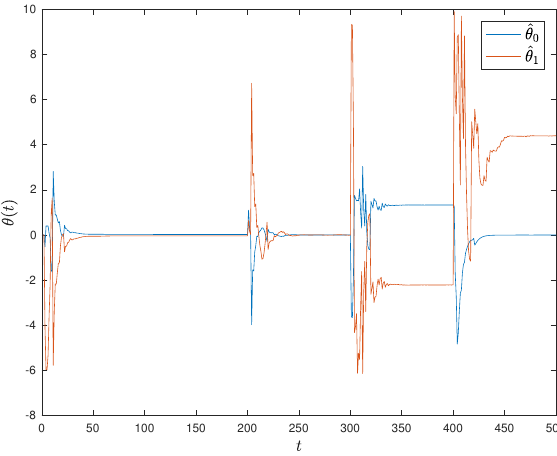
Figure 4. Parameter estimates of the anti-windup PIESC with the saturation bias update for Example